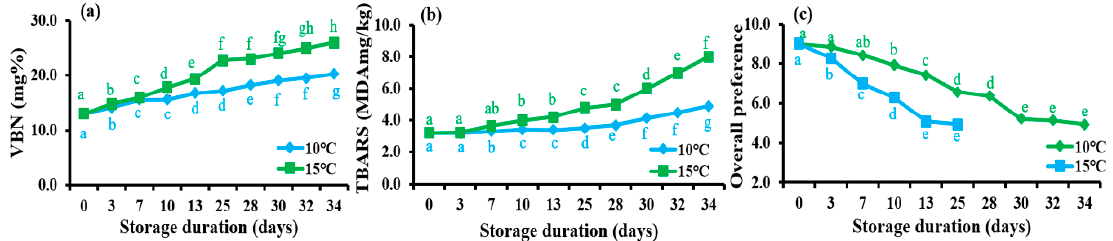
Figure 5. Changes of VBN ( a ), TBARS ( b ) and overall preference ( c ) value in hot smoked CM fillet at two different temperatures (10 and 15 ◦ C) in a storage period 0 to 34 days. The data were stated as mean ± std ( n = 10), where different letters were expressed as statistically different ( p < 0.05).